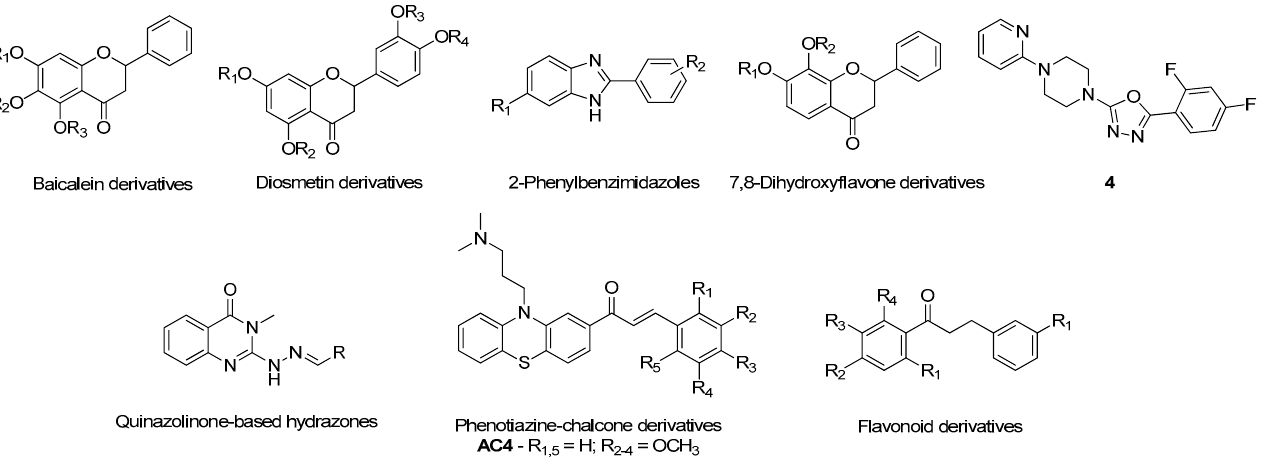
Figure 8. Structures of the studied BACE-1 inhibitors.